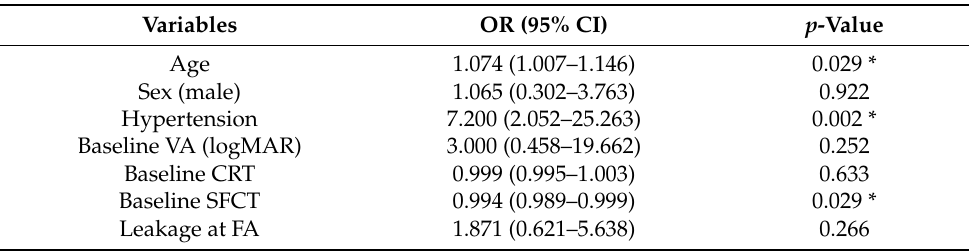
Table 3. Logistic regression analysis to investigate the association of potential risk parameters with refractory subretinal fluid in eyes with chronic central serous chorioretinopathy (CSC) treated with intravitreal bevacizumab injection (IVB) ( n =